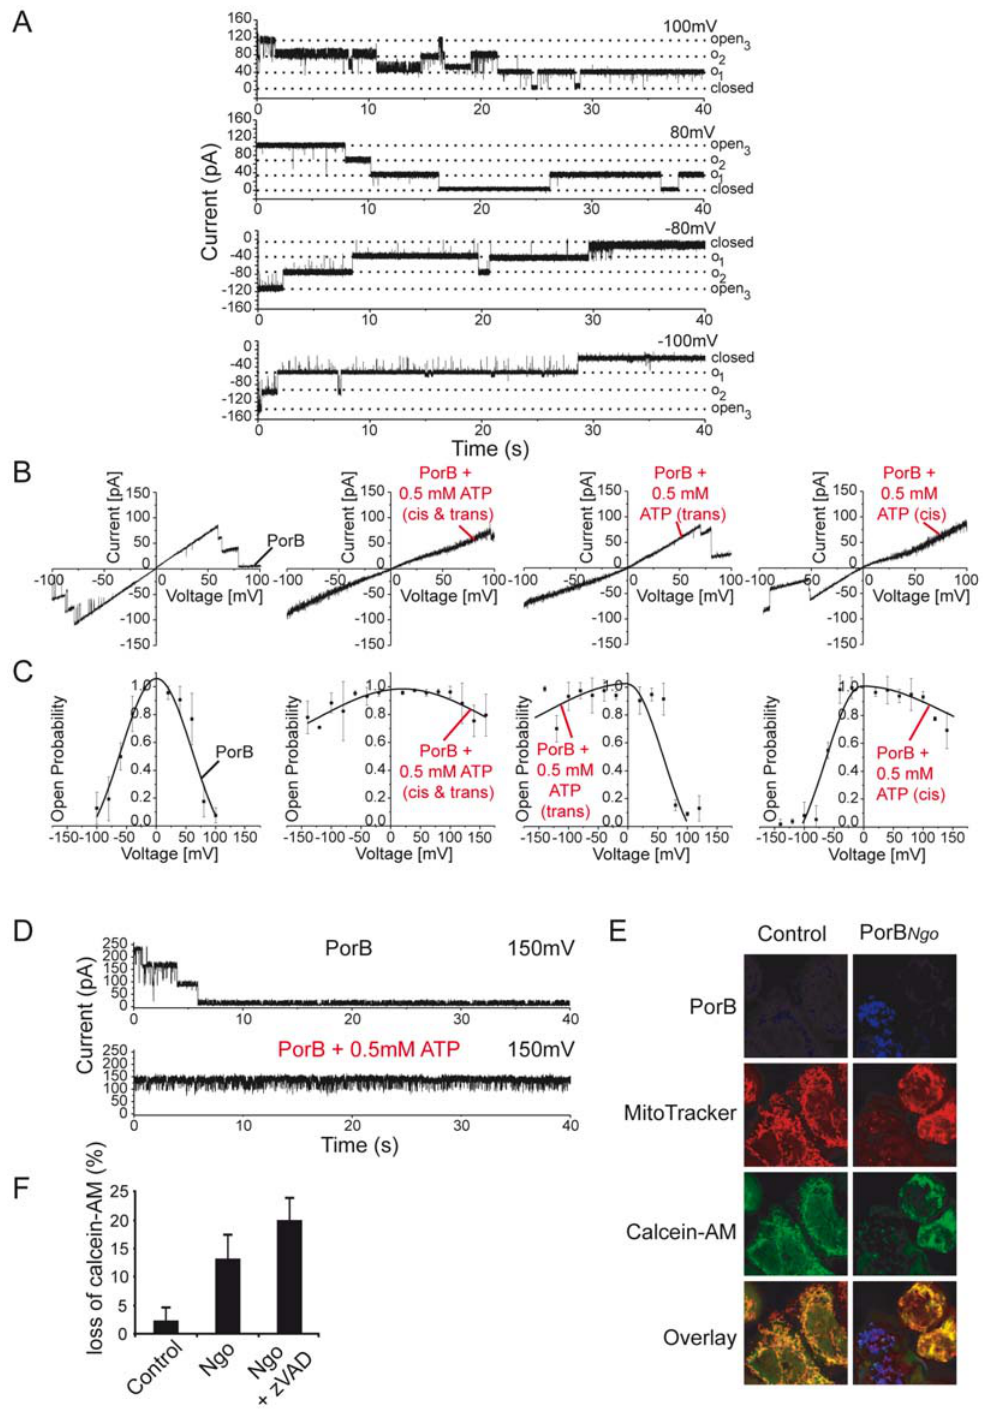
Figure 5. Electrophysiological characterization of PorB. ( A ) Typical (n $ 5 independent bilayers) current recordings of a bilayer containing PorB at indicated applied voltages. Buffer conditions were symmetrical with 250 mM KCl, 10 mM Mops/Tris pH 7.0 in cis and trans . ( B ) PorB is regulated by ATP. Current-voltage relationship of PorB in the absence or presence of ATP added at the indicated side of the membrane. Buffer conditions were as in (A) (n $ 3). ( C ) Voltage-dependent open probability of PorB in the absence or presence of ATP added to the indicated side of the membrane. Quantification was performed by comparing the mean current determined over a time range of 2 min with the maximum current at a constant holding potential (n $ 3). ( D ) Current recordings of a bilayer containing PorB in the presence of ATP at the indicated constant holding potential. Buffer conditions were as in (A) (n $ 5). ( E ) HeLa cells transfected with empty vector and porB were loaded with calcein-AM (green) and CoCl 2 as mentioned in Protocol S1. The cells were then incubated with MitoTracker orange (red) to check for membrane potential loss, and the expression of PorB (blue) was checked by costaining. The respective overlays of all the three channels are shown. ( F ) The loss of calcein-AM staining upon Ngo infection was monitored by FACS analysis. Data represent mean 6 SD of three independent experiments.